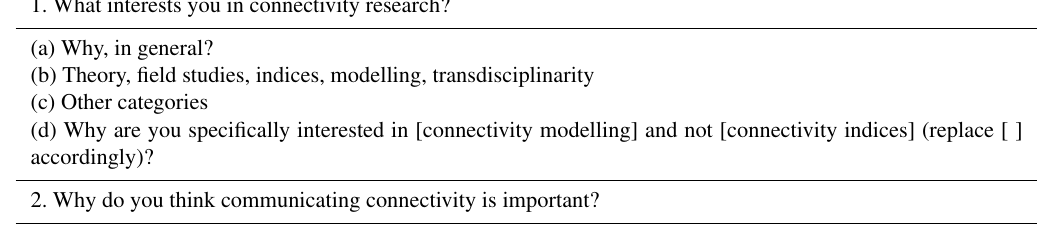
Table 1. Questions of the paired, semi-structured interviews.